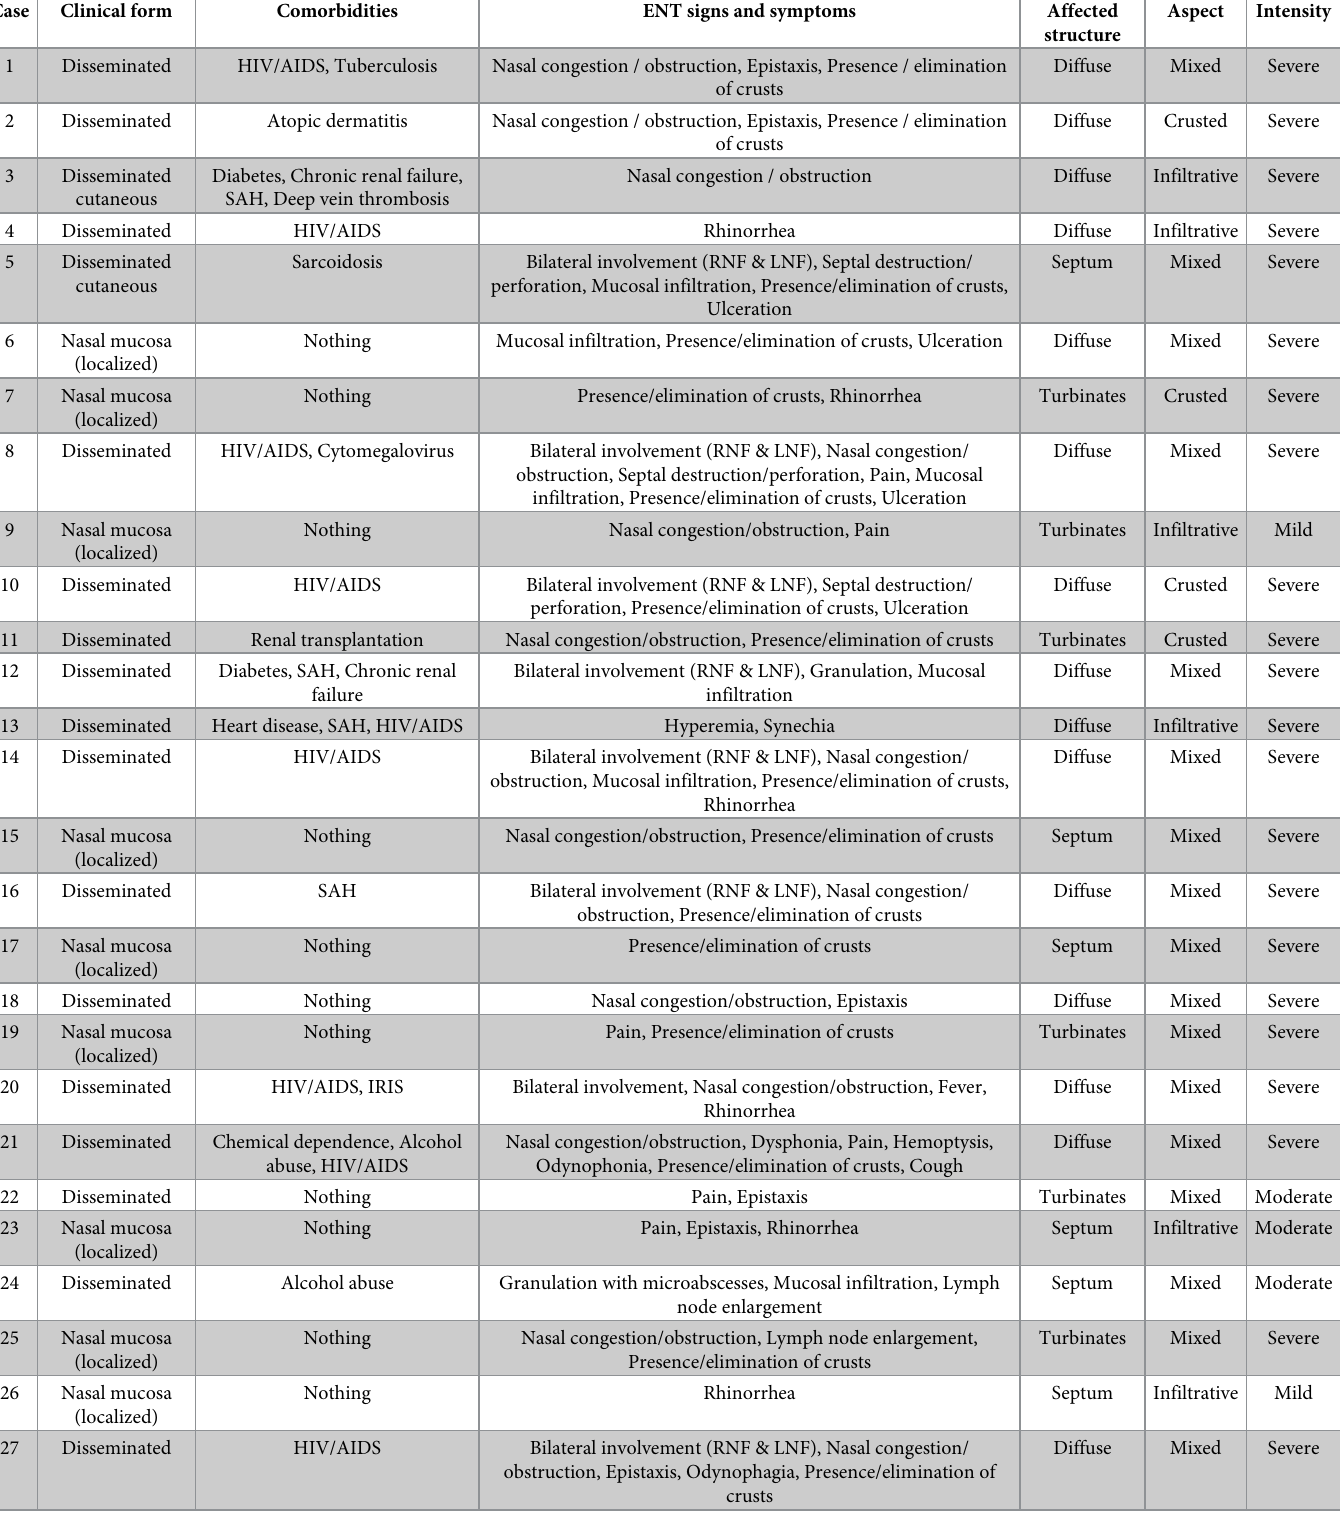
Table 1. Clinical aspects of the 37 cases of sporotrichosis in the nasal mucosa treated at the ENT outpatient clinic of the INI/FIOCRUZ